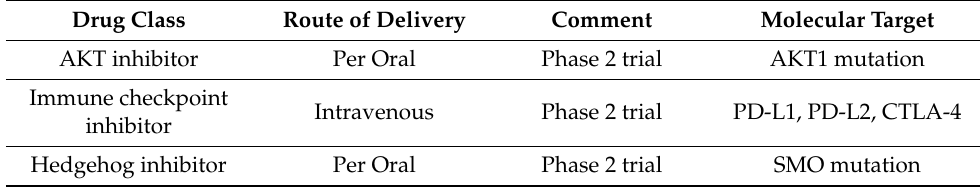
Table 2. Systemic Therapies for